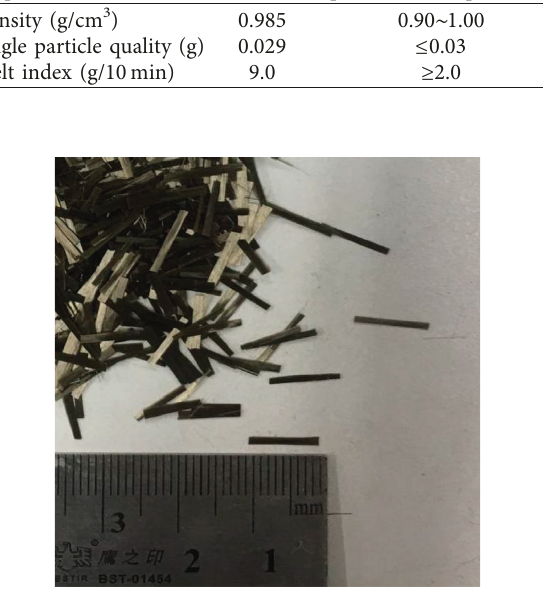
Figure 2: Chopped basalt fibers. Table 6: Properties of chopped basalt fiber.